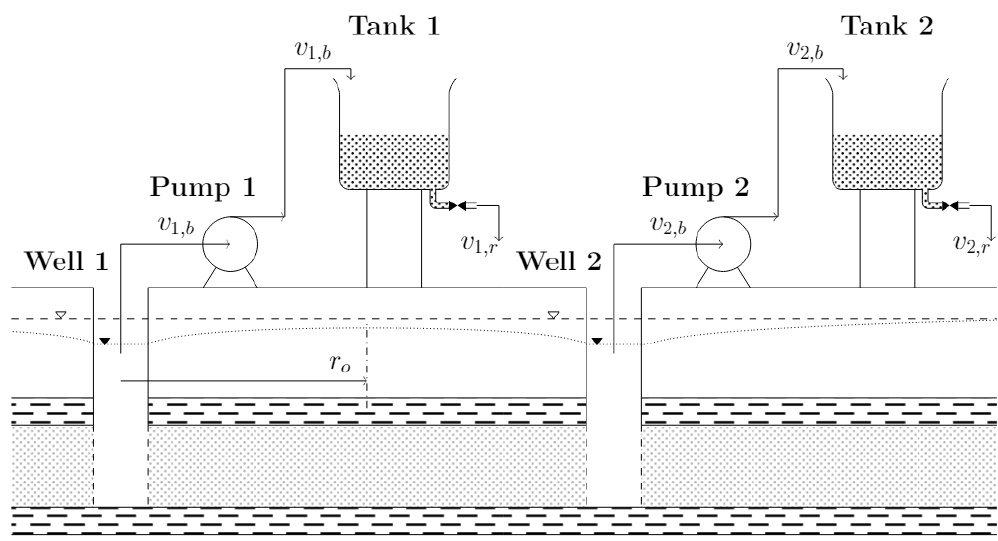
Figure 1. Schematic of the hydrological